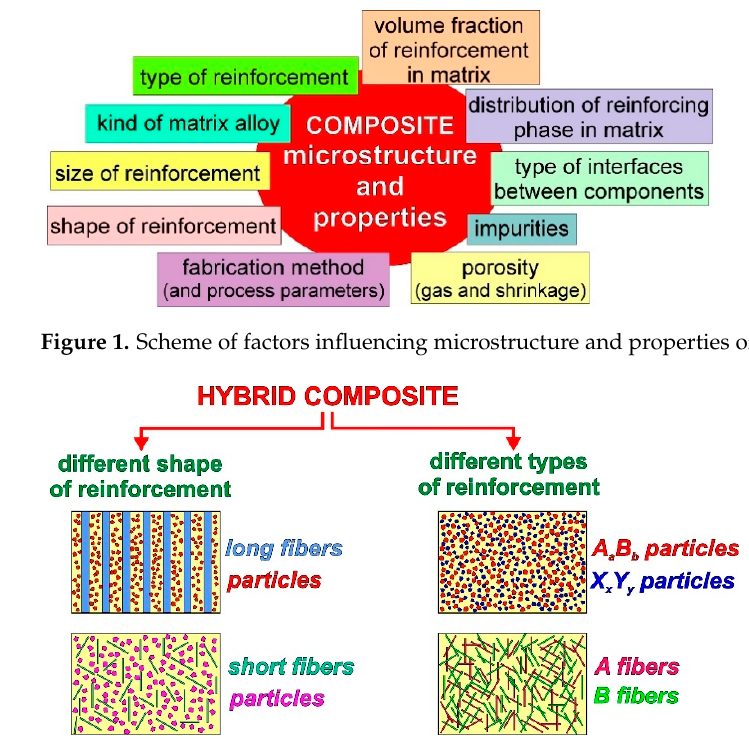
Figure 2. Scheme of various hybrid composites.